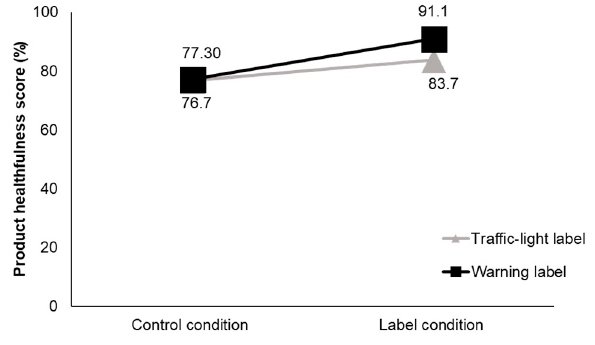
Figure 4. Product healthfulness score, measured in a product comparison task; p < 0.001 for differences between label conditions at T2.